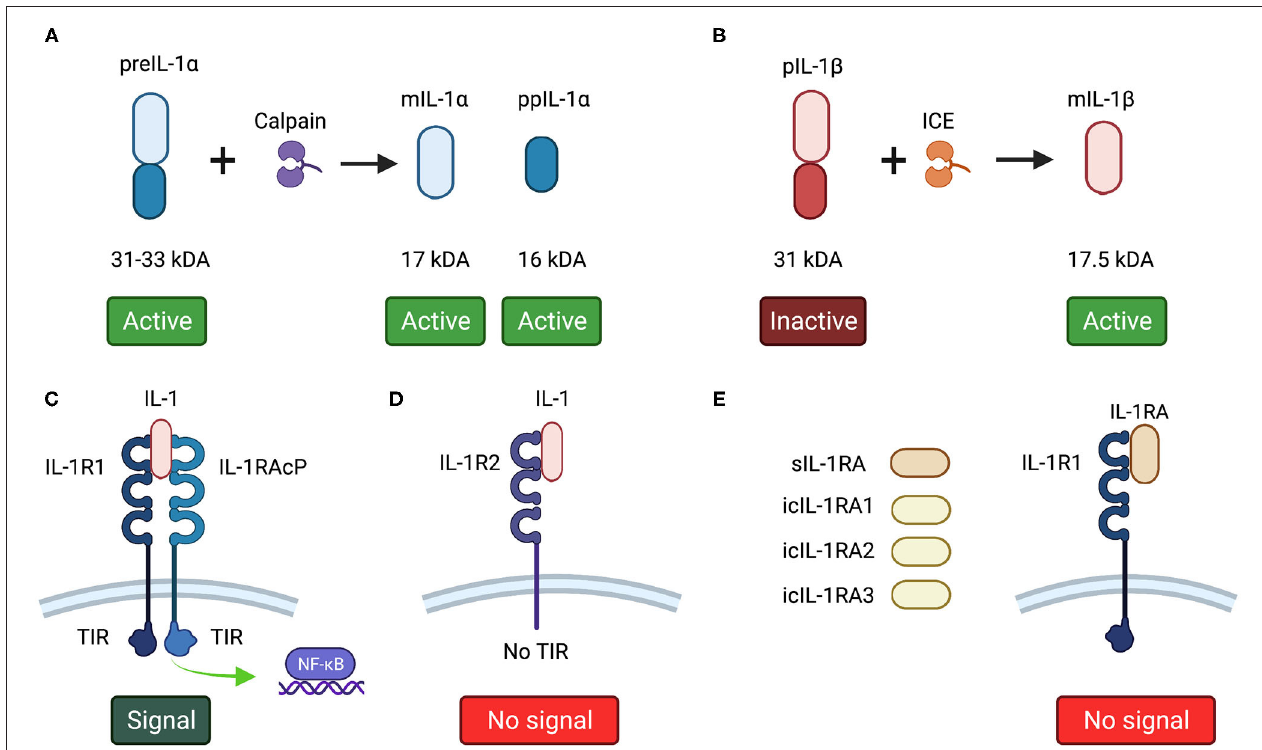
FIGURE 1 | (A) IL-1 α and (B) IL-1 β forms. (C) IL-1R1 agonist receptor. To be active, IL-1R1 needs the binding of IL-1RAcP. Both IL-1R1 and IL-1RAcP have a TIR domain, which after a series of phosphorylation following IL-1 binding, activate NF-kB. (D) IL-1R2 decoy receptor binds to IL-1 without triggering any agonist action as lacks of a TIR domain. (E) IL-1RA variants bind to IL-1R1, blocking the binding of IL-1 without recruiting IL-1RAcP, thus triggers no agonist action. This image was created with